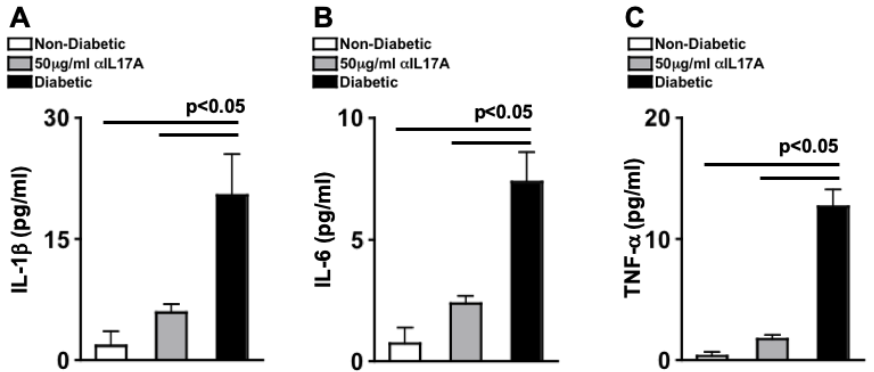
Figure 2. Acute Phase Cytokines in the Retinas of STZ-Diabetic Mice After anti-IL-17A Injection. Ella analysis of IL-1  ( A ), IL-6 ( B ), and TNF-  ( C ) in individual retinas (n = 9/group) of non-diabetic, anti-IL-17A treated, and untreated diabetic mice; 6 weeks after injection. Error bars represent the SEM. All p-values were first equated using 2- way ANOVA and then unpaired student’s t -test with sults.